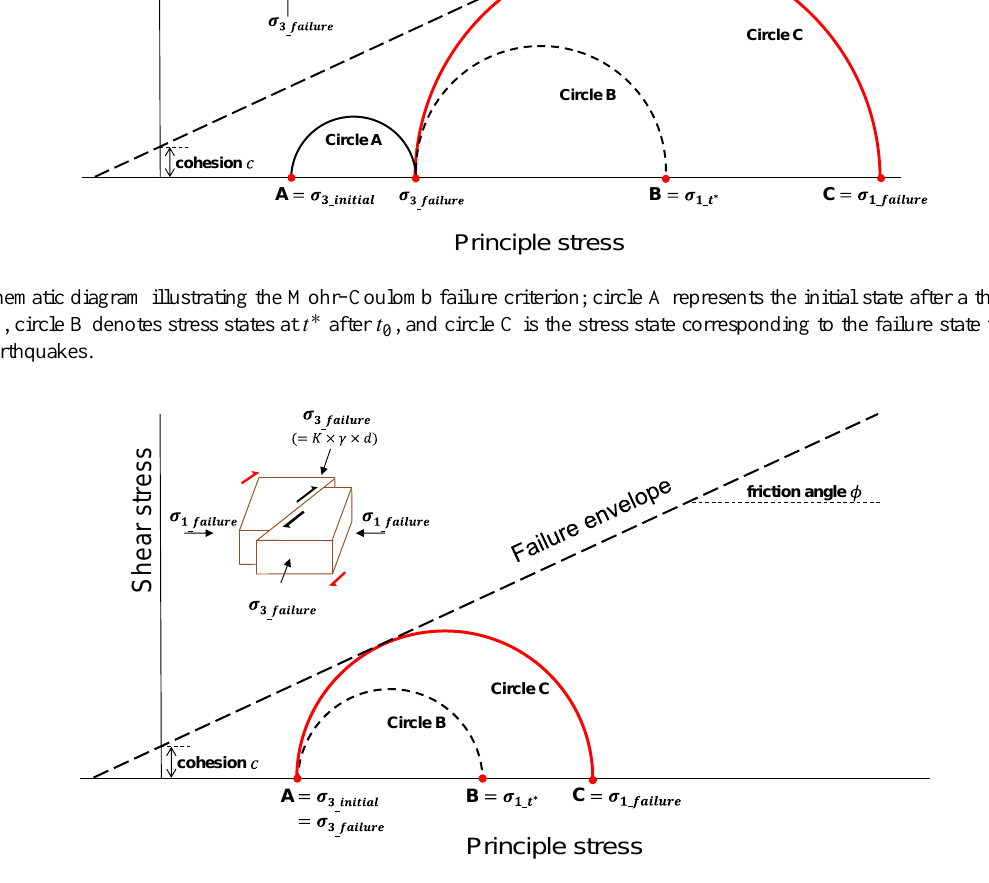
Figure 5. The Mohr circles for the non-stationary earthquake analysis for strike–slip